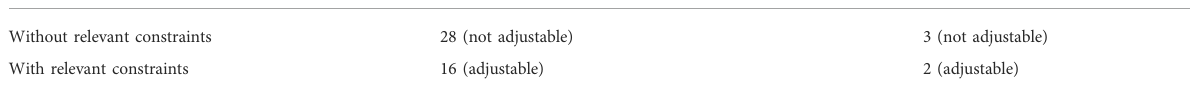
TABLE 3 Effects of IBDR with or without relevant constraints.